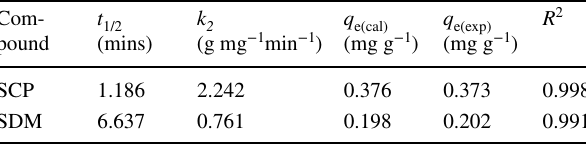
Table 3 Pseudo-second-order kinetic parameters for removal of SCP and SDM onto Fe-MC